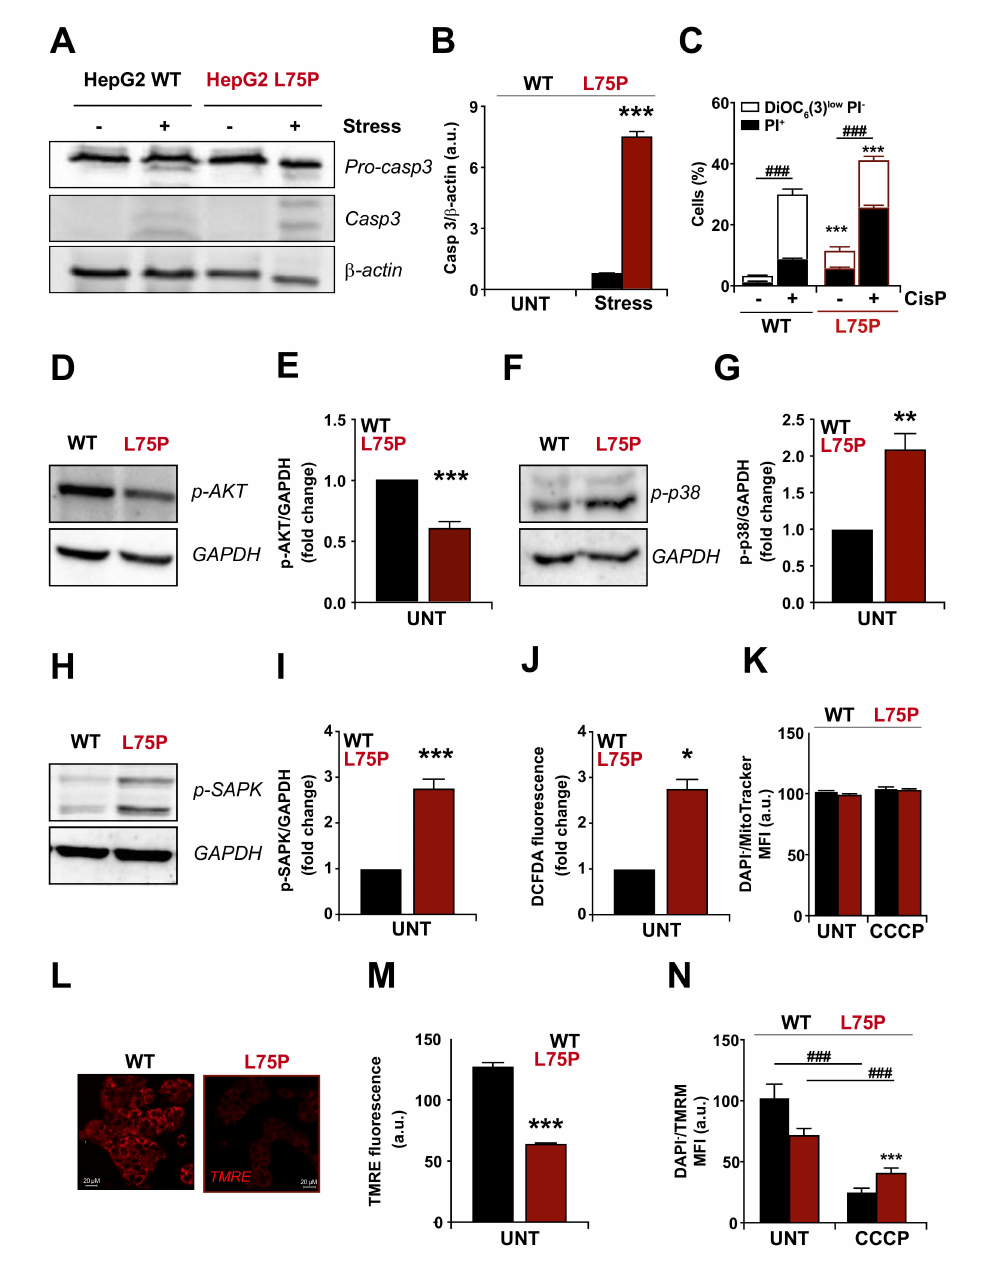
Figure 1. Alteration of cellular redox homeostasis in L75P-ApoA-I expressing cells. ( A , B ) Stress- induced apoptosis in L75P-ApoA-I expressing cells. Wild type (WT) or L75P-ApoA-I (L75P) HepG2 cells were cultured in control conditions (UNT) or maintained in FBS-free medium (stress) and analysed by immunoblotting with antibodies specific for caspase-3 (Casp3) and β -actin (loading control). Apoptosis activation coincides with a reduction in the intensity of the pro-caspase 3 band paralleled by an increase of the bands corresponding to the active fragments (the relative densitometry is shown; means ± SD of at least three independent experiments). ( C ) Cytometric quantification of cell death induced by cisplatin treatment (CisP). WT and L75P HepG2 cells were treated, collected, and double stained with PI and DiOC 6 (3) for the detection of dying (DiOC 6 (3) low -PI − ) and dead (PI + ) cells. ( D – I ) Mechanistic insights of L75P-ApoA-I expressing cells. WT and L75P HepG2 cells were cultured in control conditions, followed by the assessment of AKT ( D , E ), p38 ( F , G ) and SAPK/JNK ( H , I ) phosphorylation (the relative densitometry is shown). GAPDH levels were monitored to ensure equal loading of lanes. ( J – N ) Expression of L75P-ApoA-I causes significant mitochondrial